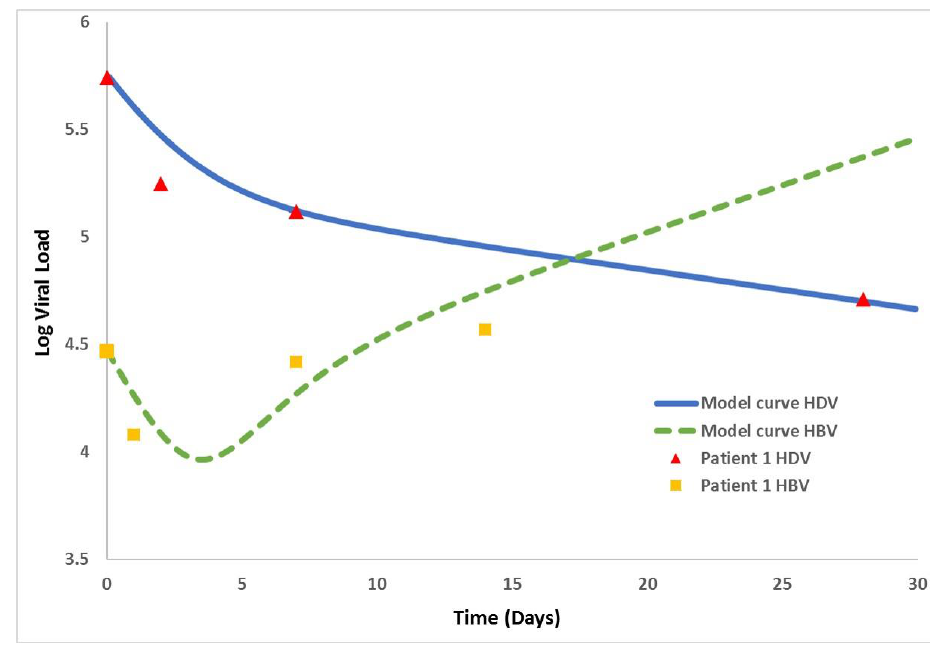
Figure 2. Patient 1 HDV/HBV levels after LNF treatment initiation (first 28 days).